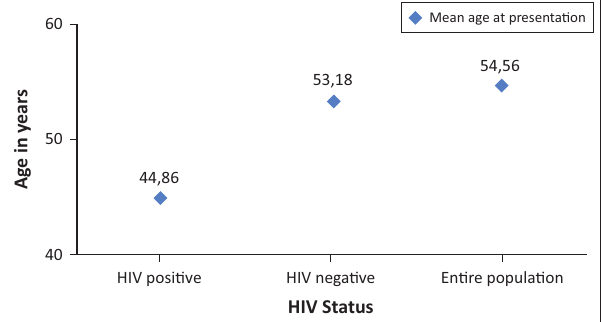
FIGURE 3: Mean age at presentation.